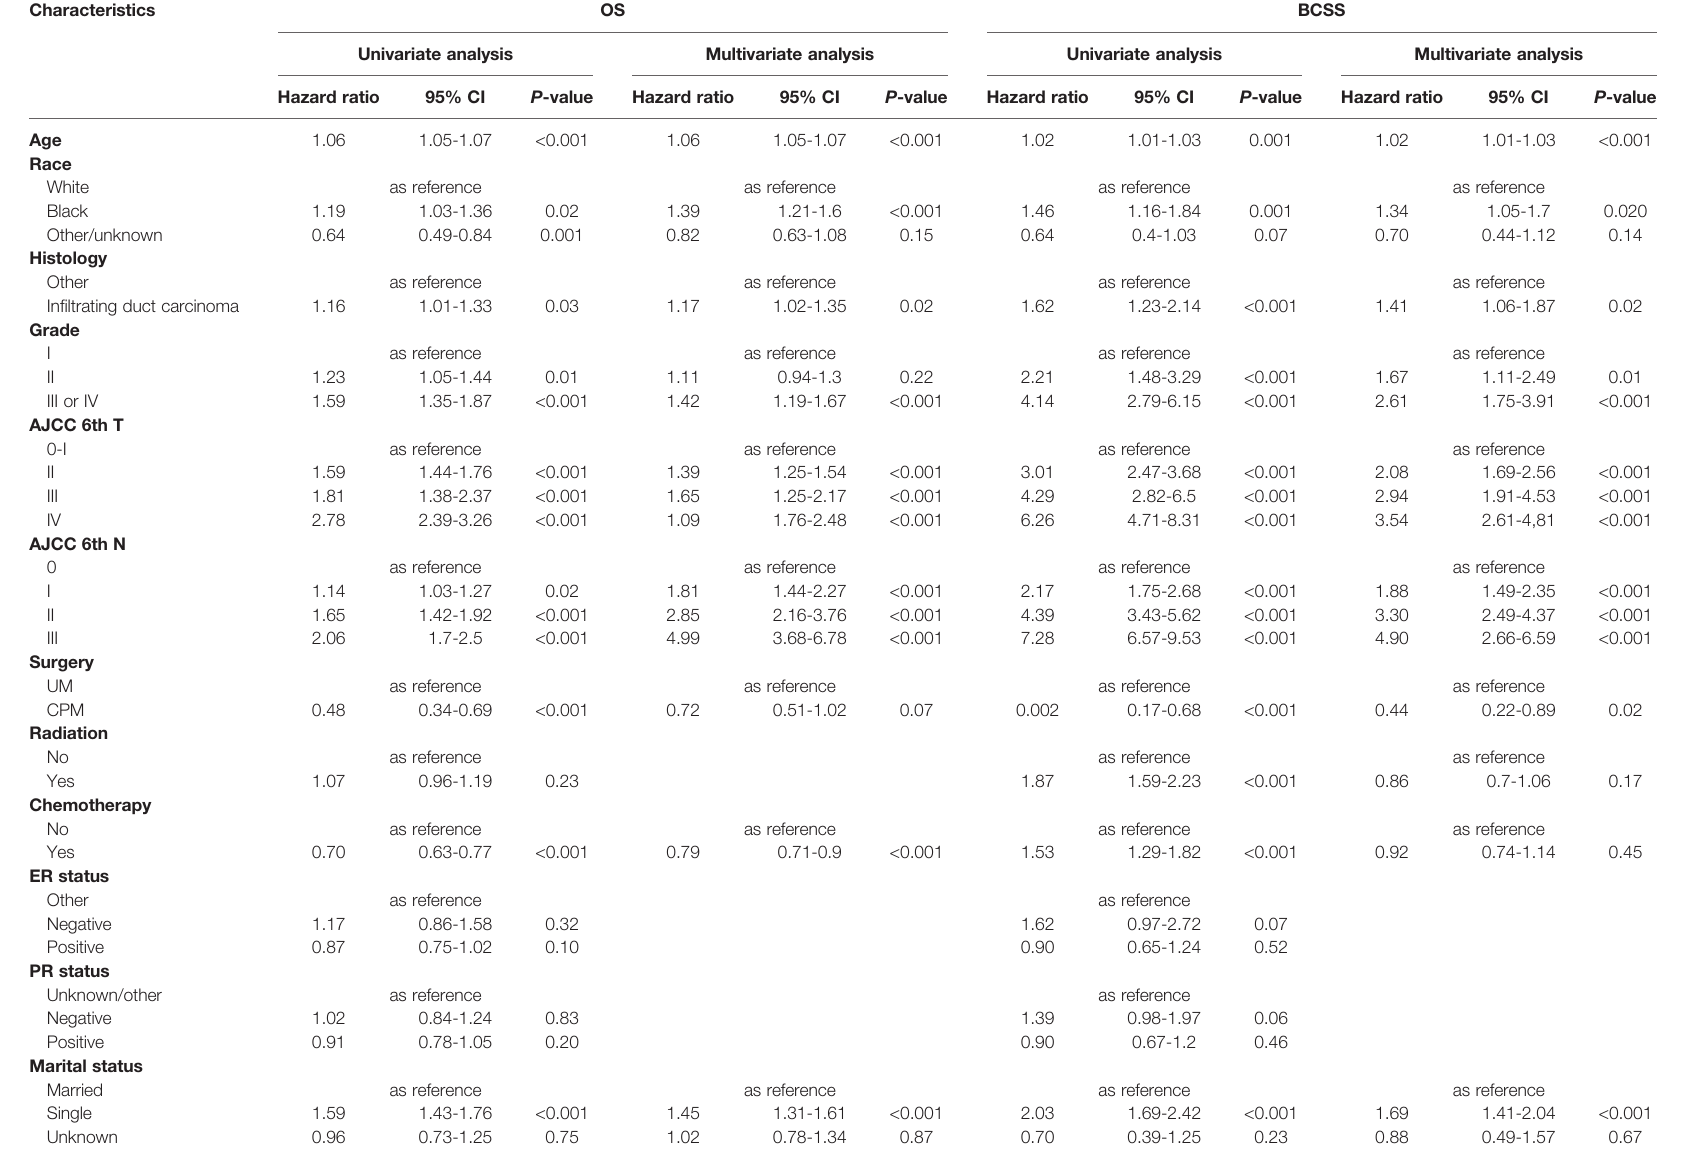
TABLE 2 | Univariate and multivariate Cox regression model analysis of MaBC